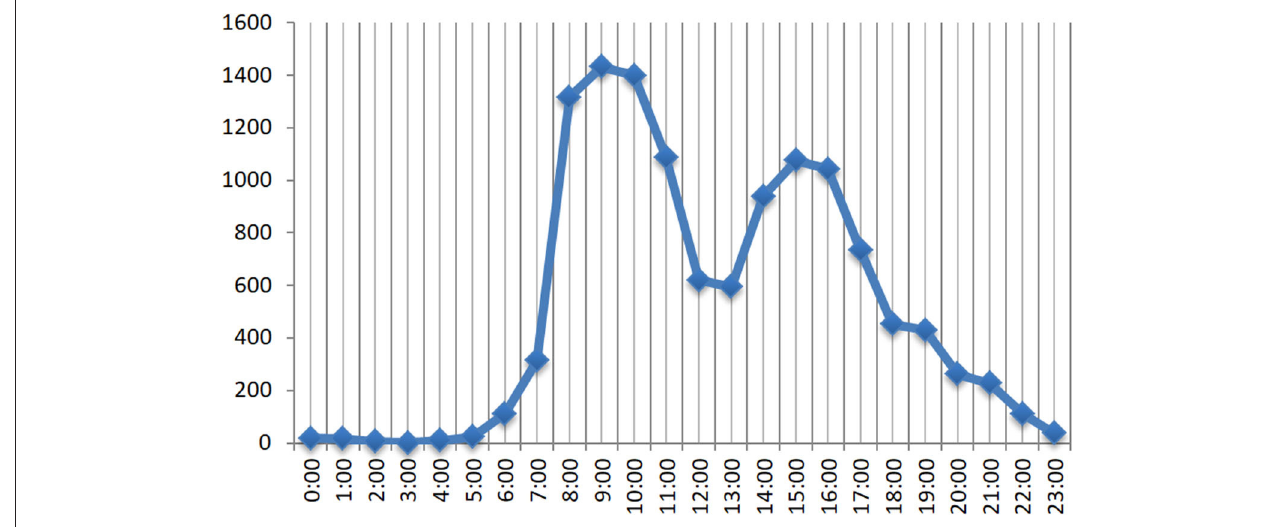
FIGURE 10 | The number of incoming calls at different times of the